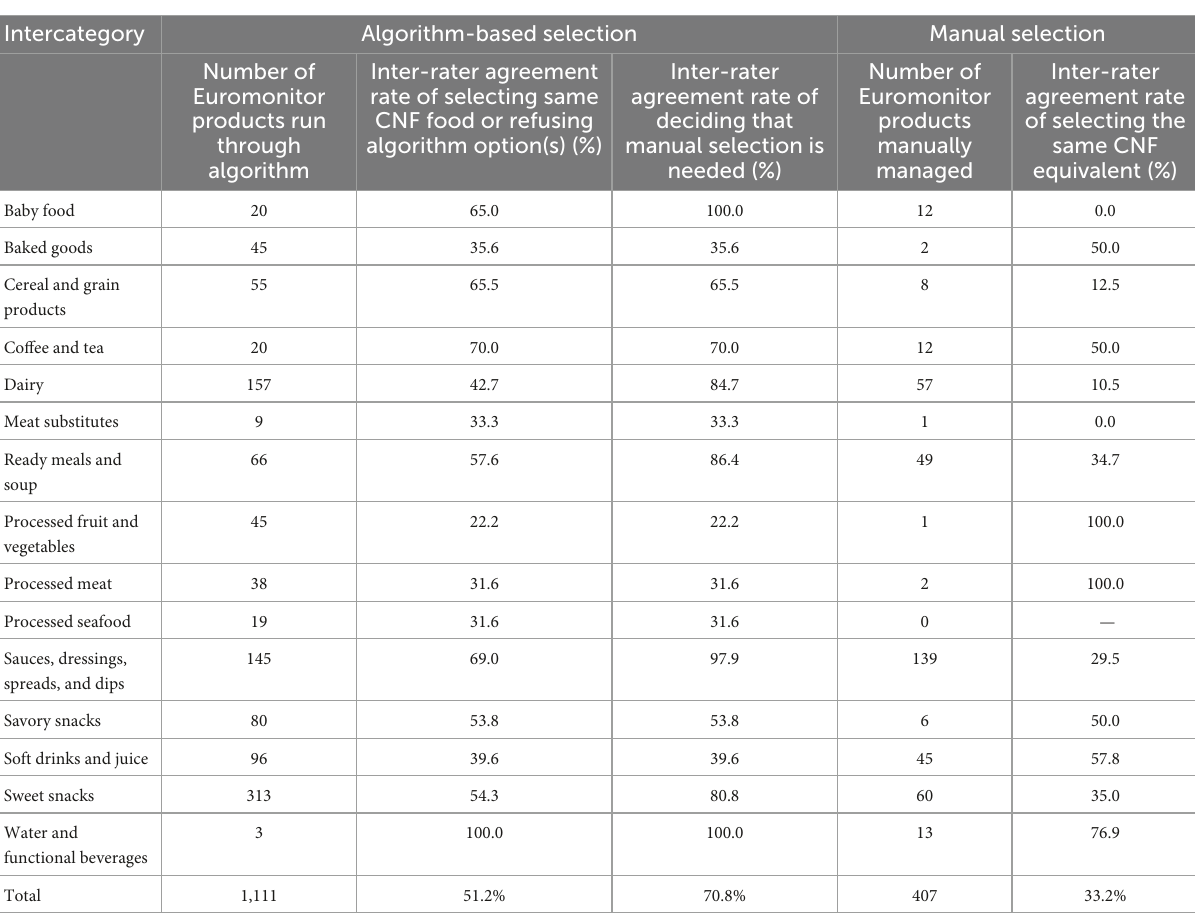
TABLE 5 Inter-rater agreement rates in the algorithm-based and manual selection processes. Intercategory Algorithm-based